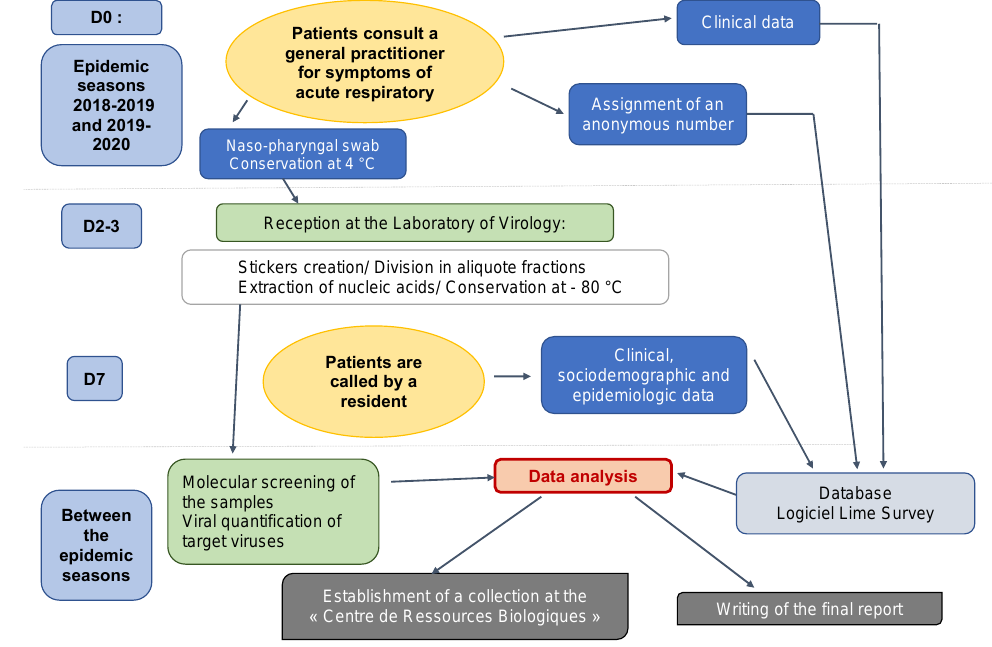
Figure 2. ECOVIR’s workflow. Each week was scheduled as follows: inclusions on Mondays, Tuesdays, and Wednes- days; transport of samples to the virology laboratory by our team on Thursdays; and analyses on Fridays (Figures 2 and